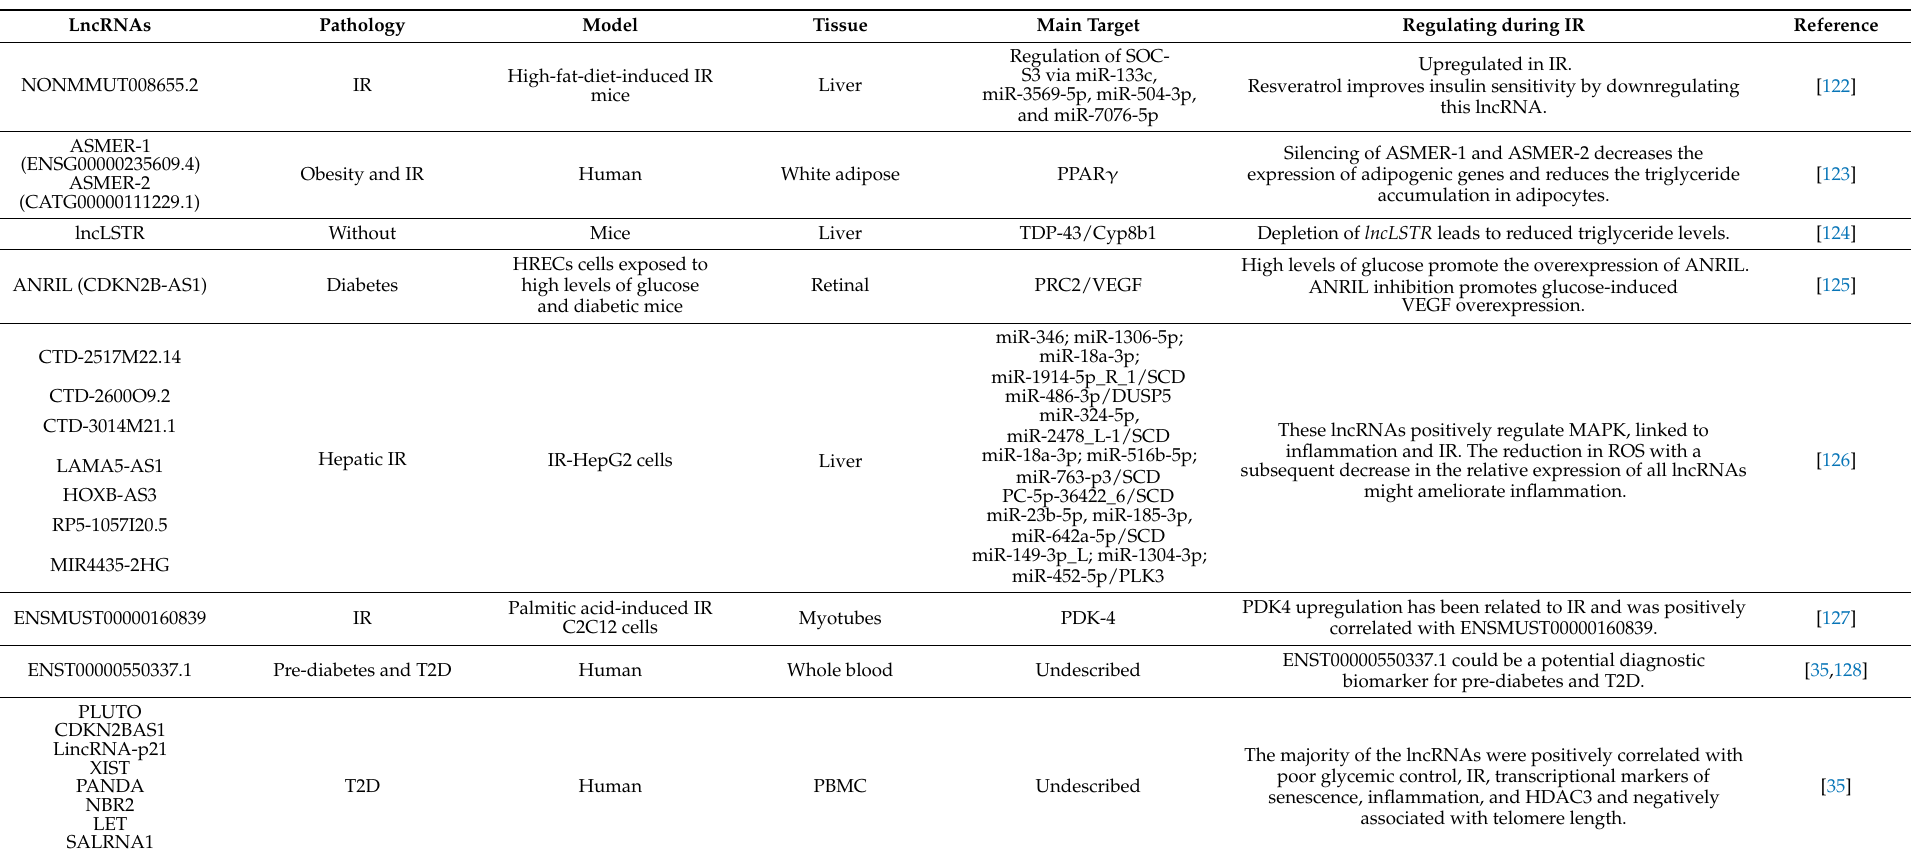
Table 1. Roles of other lncRNAs in molecular mechanisms associated with insulin resistance and related